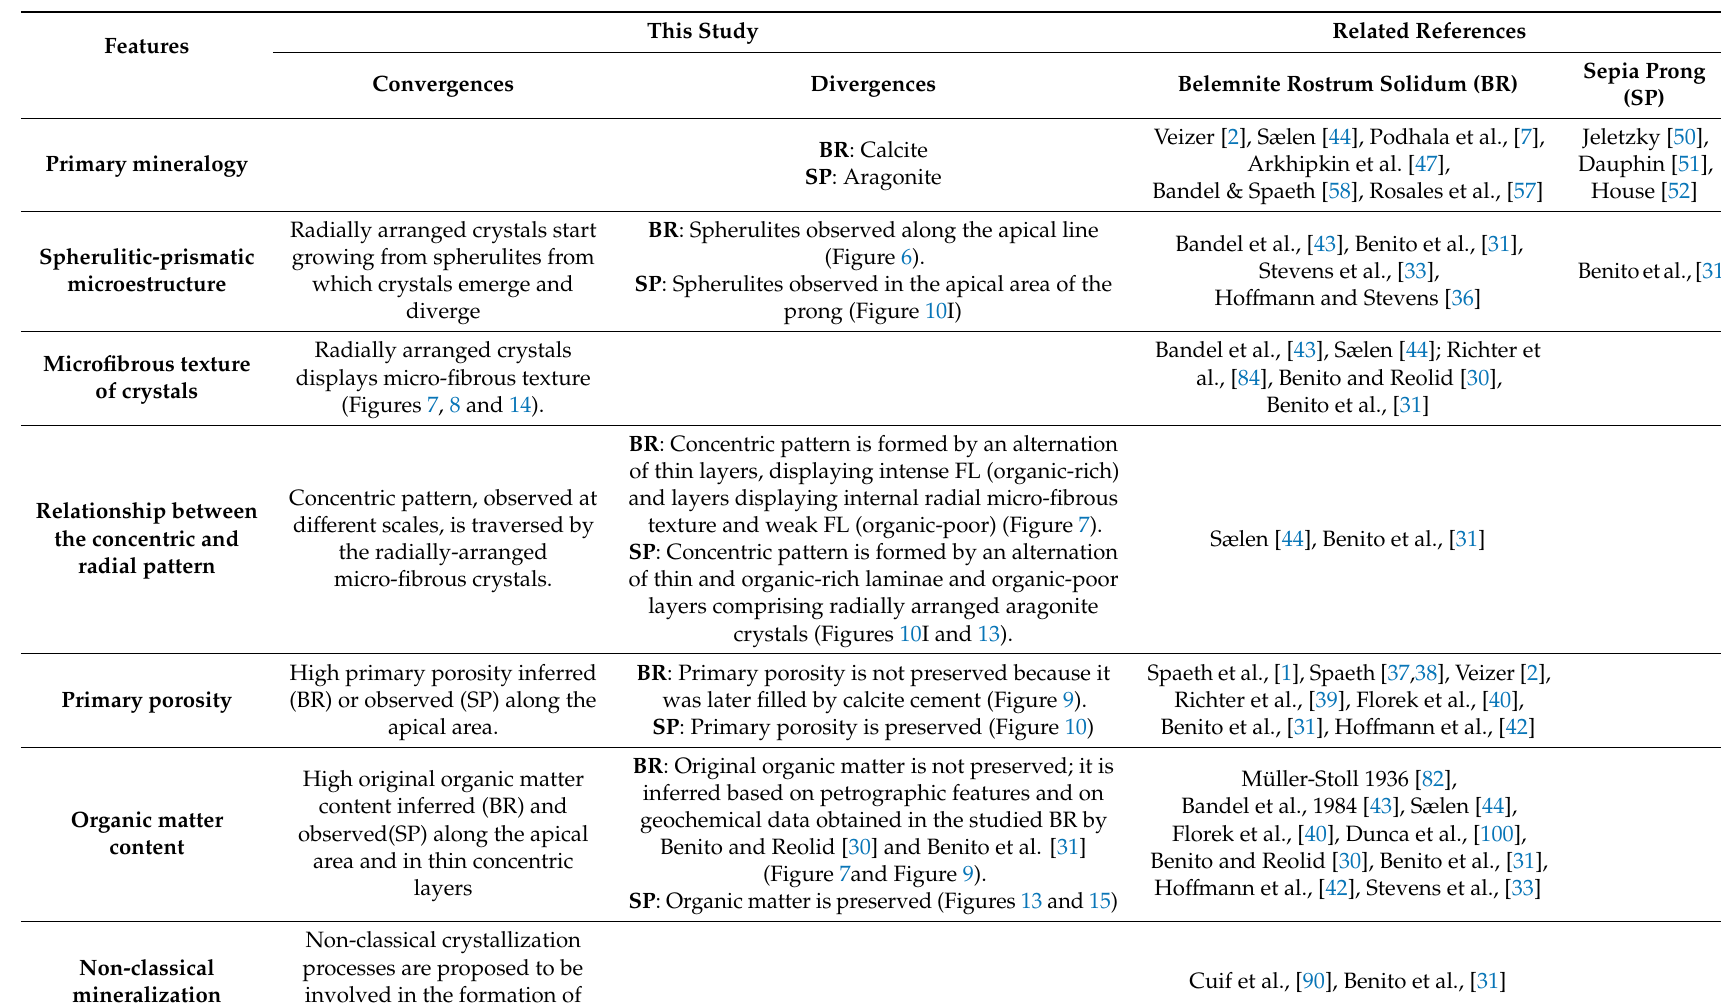
Table 1. Summary of the main convergences and divergences observed between the rostrum solidum of belemnites (BR) and the Sepia prong